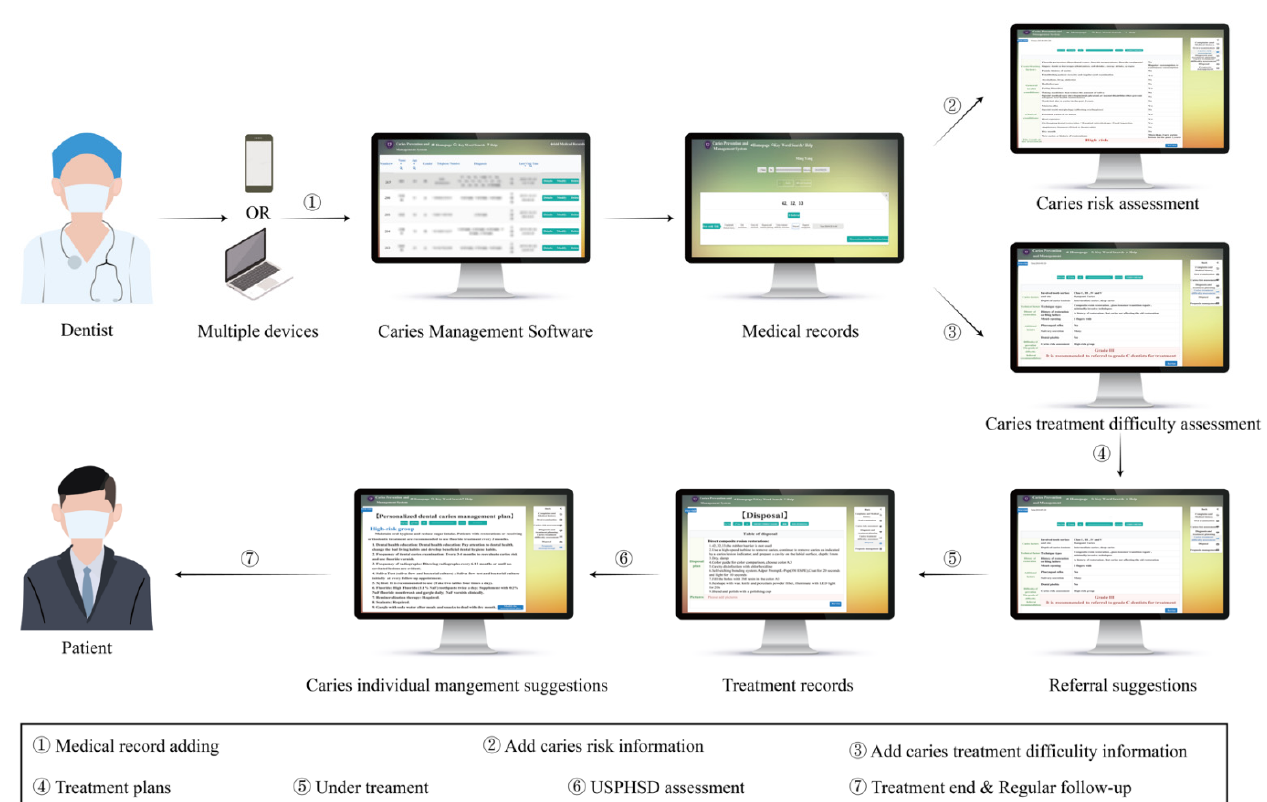
Figure 1. Application process of Caries Prevention and Management Software.